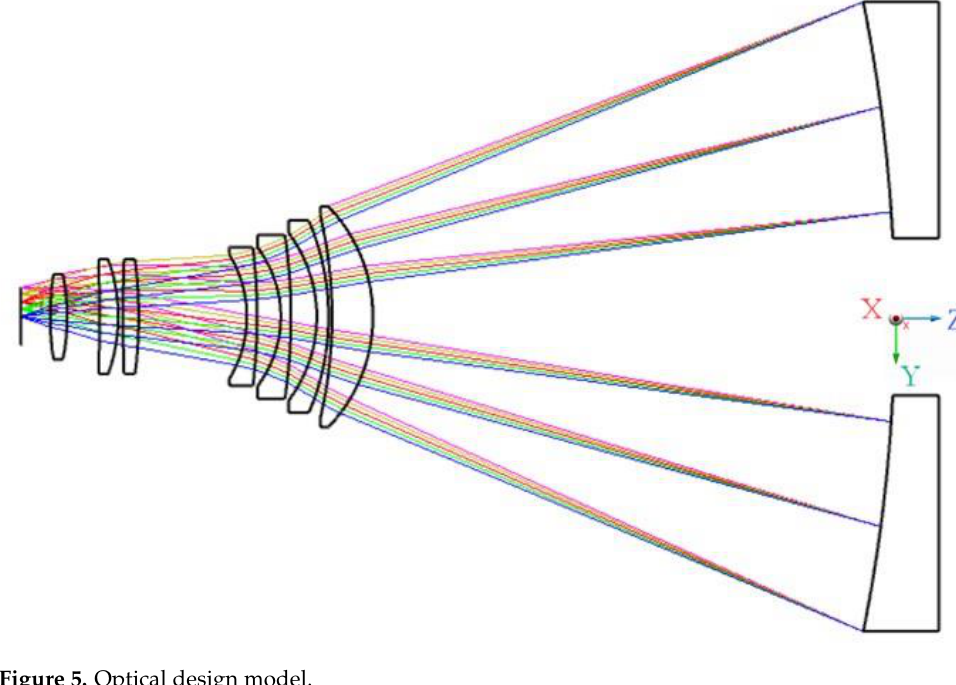
Table 4. Optical design parameters.